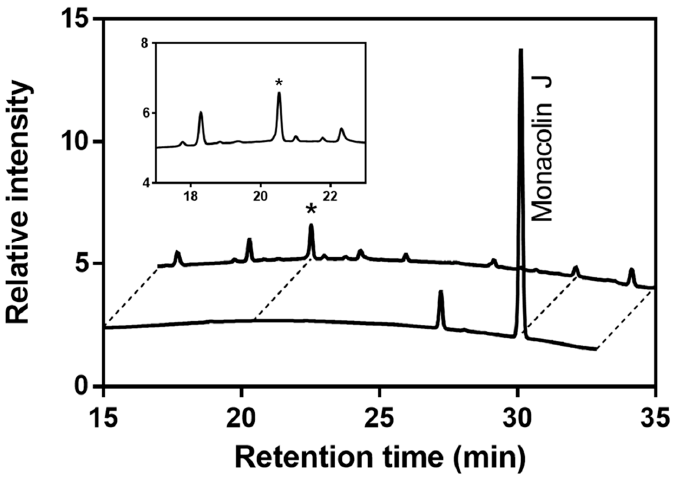
Figure 2. HPLC chromatograms of monacolin J and its products when using CYP102A1 M697. The peaks of the reaction mixtures were identified by comparing their retention times: a major product of monacolin J ( t R = 20.4 min) and monacolin J ( t R = 30.2 min). The star marks the major product.